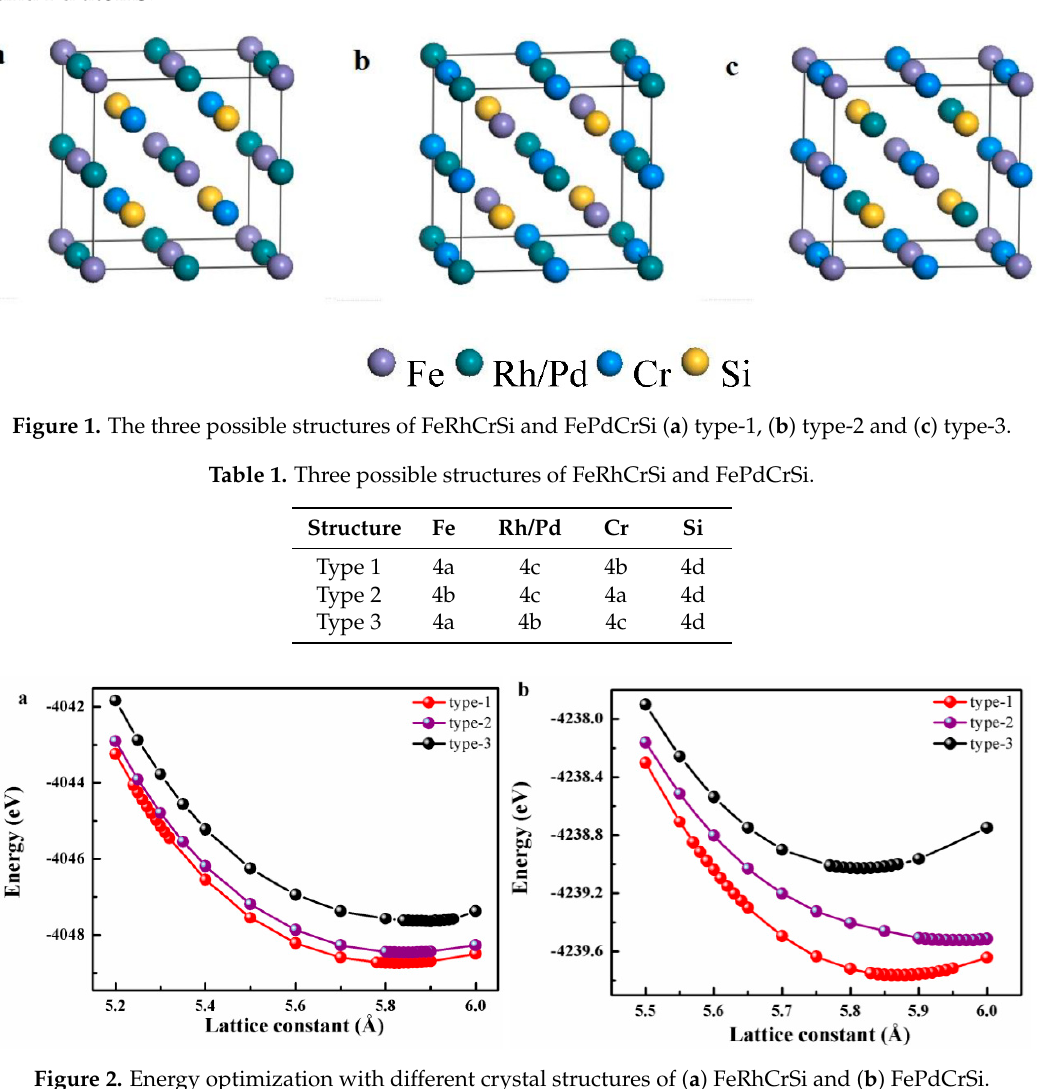
Table 1. Three possible structures of FeRhCrSi and FePdCrSi. Table 2. The optimized equilibrium lattice constant a 0 (Å), the total and partial magnetic moments ( μ B ) at the equilibrium lattice, the formation energy E f and cohesive energy Ec (eV) for the equiatomic quaternary Heusler (EQH) compounds FeRhCrSi and FePdCrSi.